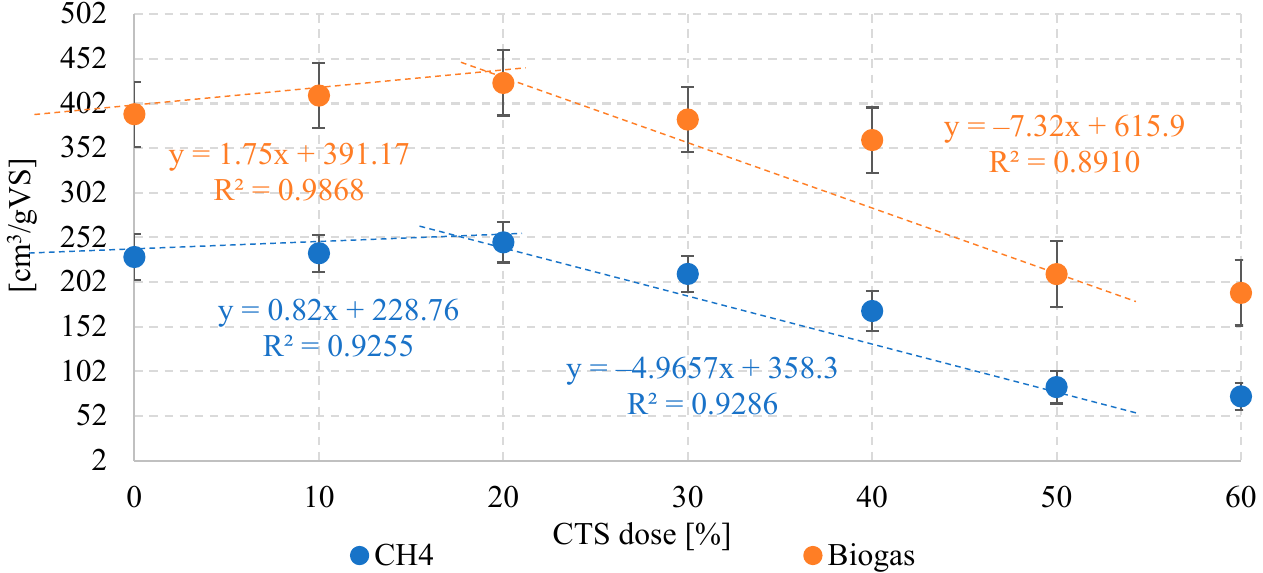
Figure 1. Biogas and methane production vs. CTS% in the feedstock.